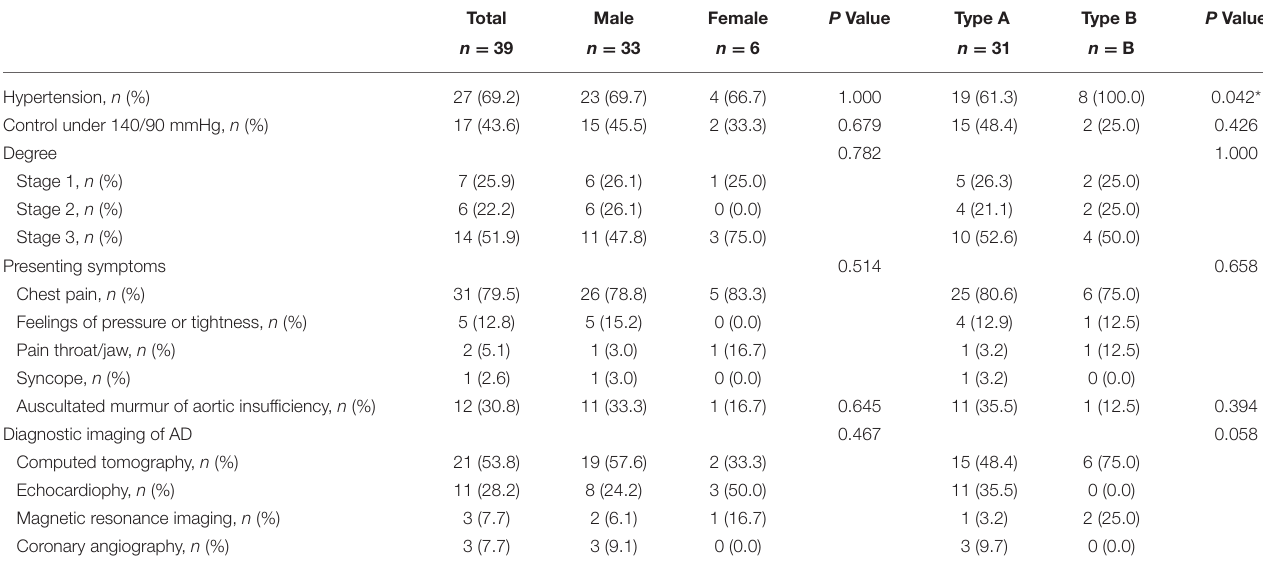
TABLE 2 | Presenting symptoms and physical examination of patients with acute myocardial infarction and aortic